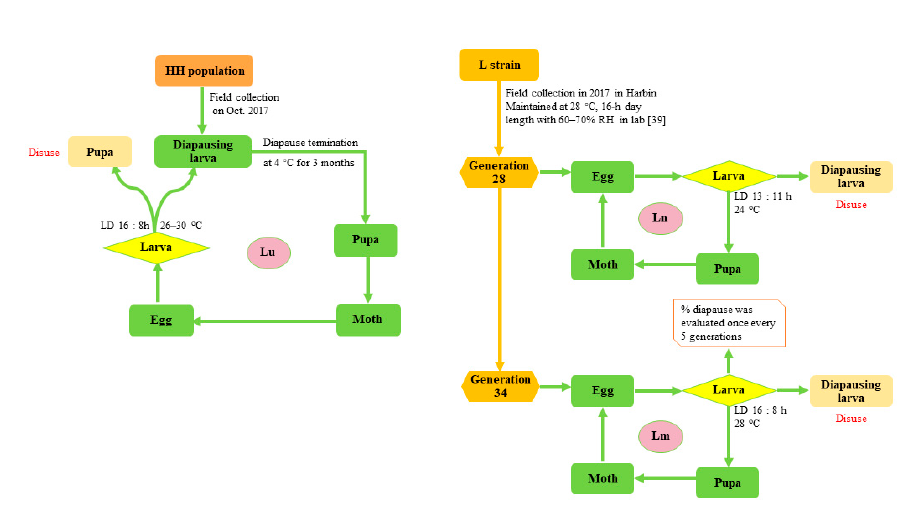
Figure A1. Selection process for Lu, Lm, and Ln strains.